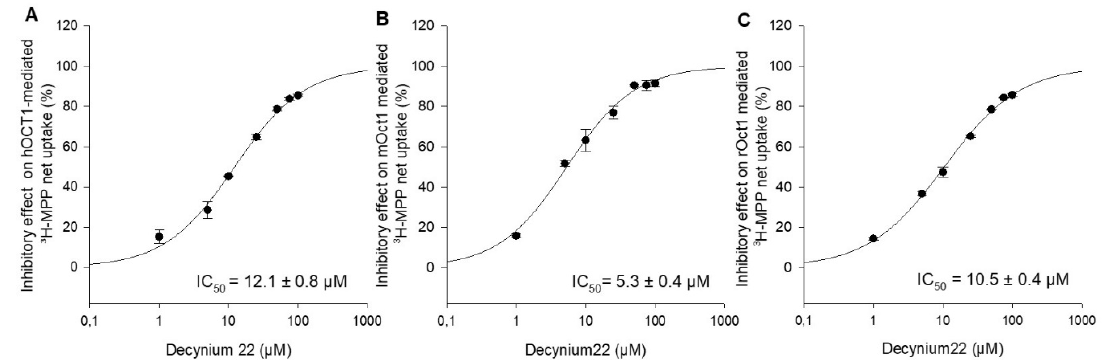
Figure 3. Inhibitory effects of decynium22 on ( A ) hOCT1-, ( B ) mOct1-, and ( C ) rOct1-mediated 3 H-MPP transport in stable transfected HEK293 cells. Uptake of MPP at Km value was measured in the presence of increasing concentrations of decynium22 (1–100 µM). Each data point represents the mean inhibitory effect (%) calculated from the net-uptake of two independent experiments ± average deviation. Each experiment was carried out in triplicates. IC 50 values were calculated by sigmoidal 3Hill analysis using Sigma Plot 13.0 software.